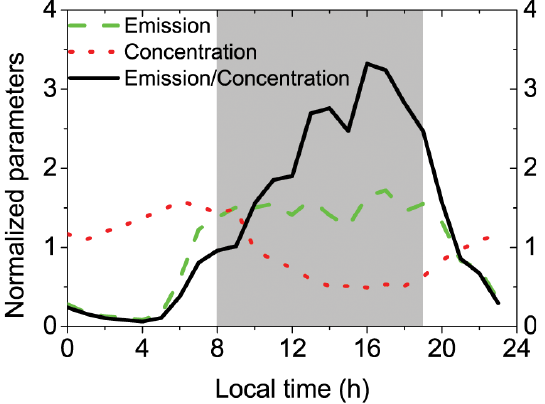
Fig. 5. Diurnal variation of normalized parameters: (a) emission rates of EC, (∂ [ EC ] /∂t) Emis , which is assumed the same as CO emission rates in Beijing (green dashed lines); (b) EC concentra- tions measured by an online Sunset EC/OC analyzer (red dotted lines); and (c) ratio of emission rate to EC concentration (black solid lines). All parameters are normalized by their diurnal means, respectively. Shaded areas represent the time period of 08:00– 19:00LT when vertical mixing is supposed to significantly affect EC